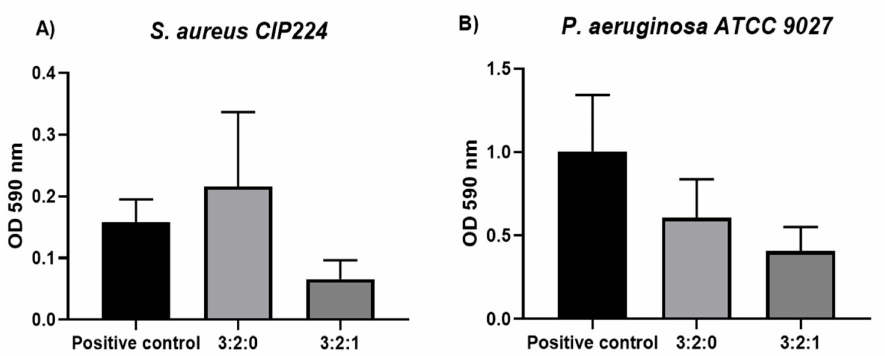
Figure 8. Antibiofilm evaluation in a hydroxyapatite-coated peg over time for ( A ) S. aureus and ( B ) P. aeruginosa . The bacterial biofilm absorbance after exposure to an extraction medium of CHT/CD/CN hydrogels was measured by OD at 590